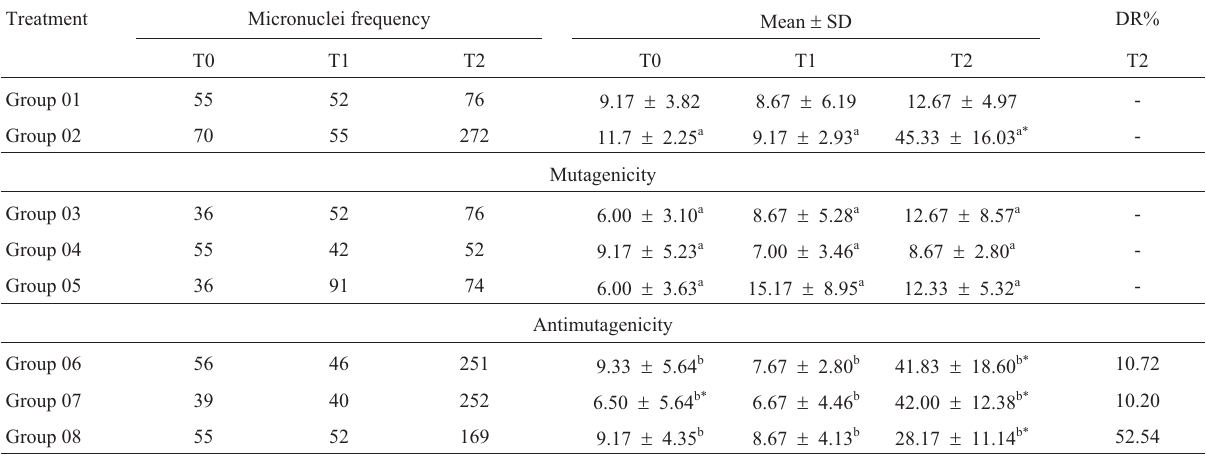
SD: Standard deviation, DR%: Damage reduction percentage. a Statistically compared to the control (Group 01). b Statistically compared to the dam- age-inducing agent (Group 02). *Statistically significant difference (unpaired Student’s t-test, p < 0.05). Time points T0, T1 and T2: samples of blood taken within interval of 24